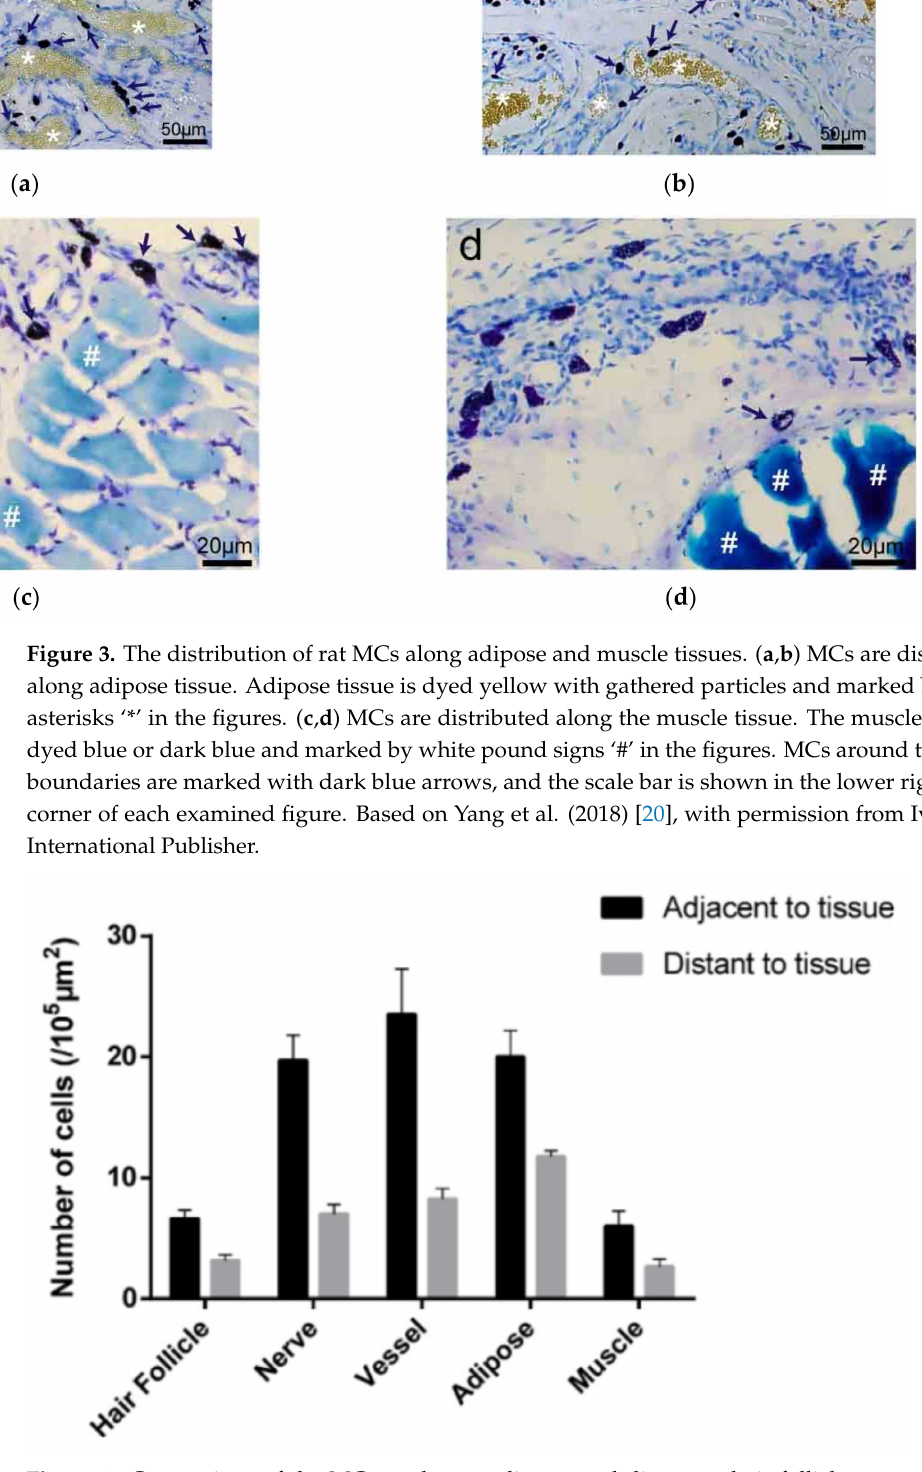
Figure 4. Comparison of the MC number at adjacent and distant to hair follicles, nerves, blood vessels, adipose and skeletal muscles in rats. Data represent means + SEM ( n = 4–7) and are based on Yang et al. (2018) [20], with permission from Ivyspring International